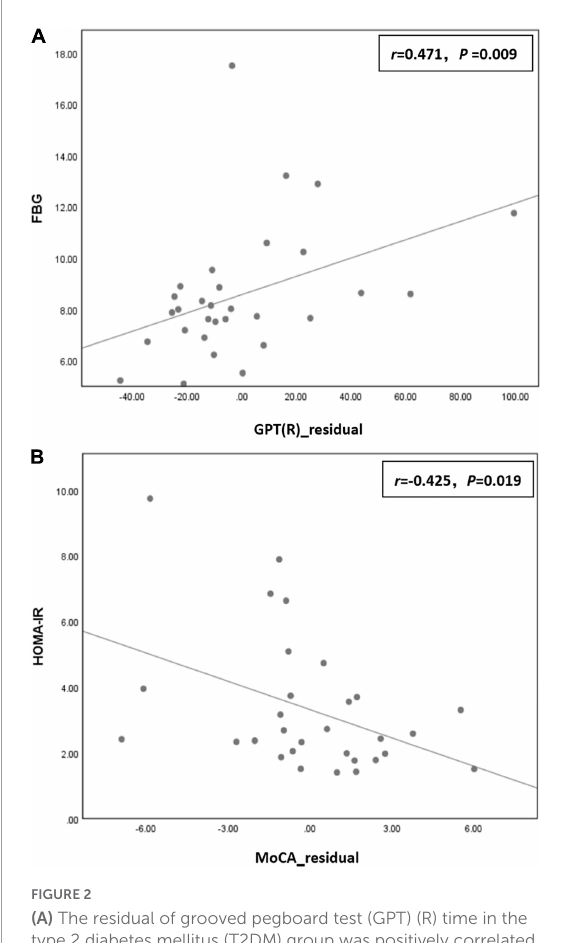
FIGURE2 (A) The residual of grooved pegboard test (GPT) (R) time in the type 2 diabetes mellitus (T2DM) group was positively correlated with fasting blood glucose (FBG) ( r = 0.471, P = 0.009) in the T2DM group. (B) The residual of the Montreal cognitive assessment (MoCA) score was negatively correlated with homeostatic model assessment for insulin resistance (HOMA-IR) ( r = –0.425, P = 0.019) in the T2DM group.